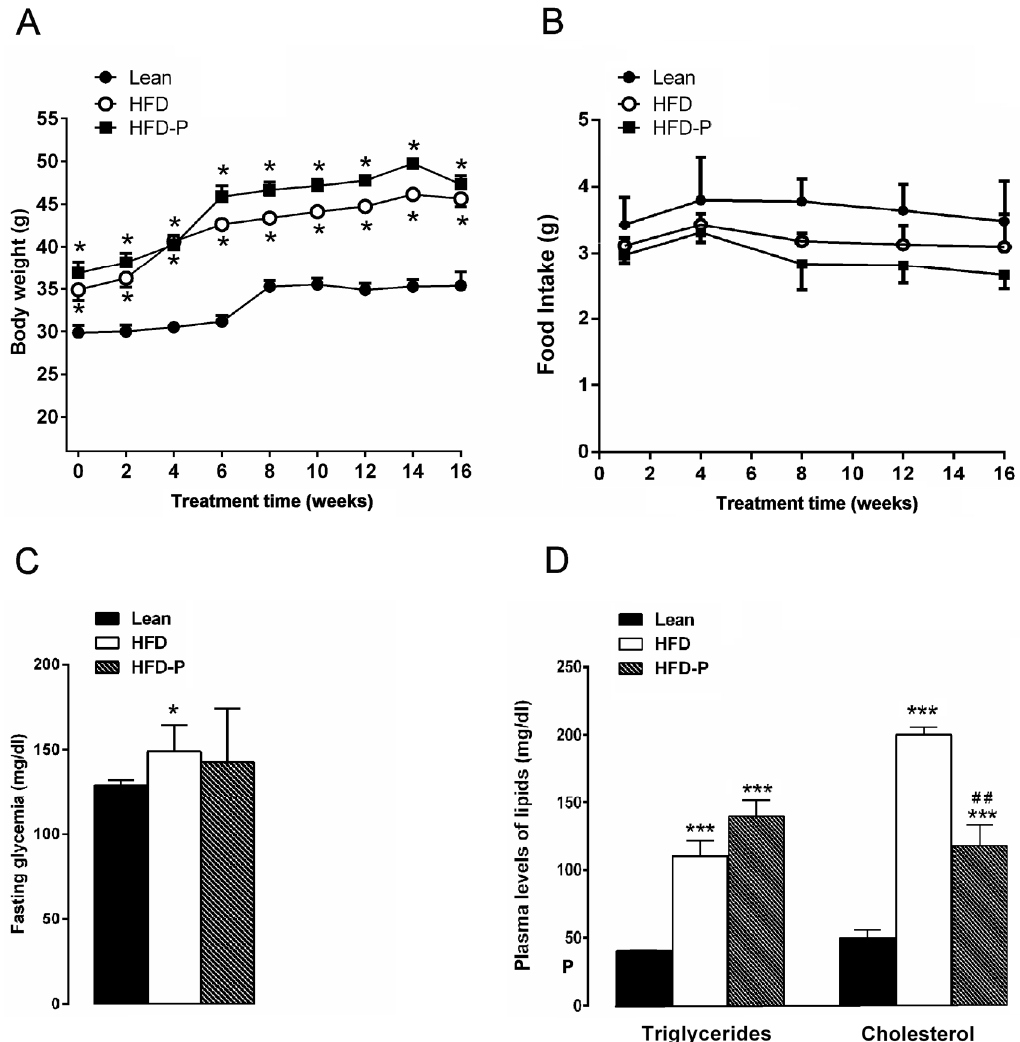
Figure 5. Pistachio consumption effects on body weight, food intake, fasting glycaemia, and plasma lipid levels in mice with ascertained obesity. Pistachio regular intake improves hypercholesterolemia. Body weight ( A ), food intake ( B ), fasting glycaemia ( C ), and plasma lipid levels ( D ) in lean, HFD, and HFD-P mice. Data are the means ± S.E.M. ( n = 8/group). Asterisk denotes significant difference compared with the lean group (* p < 0.05; ** p < 0.01; *** p < 0.001;); hash denotes significant difference compared with the HFD group ( # p < 0.05; ## p < 0.01; ### p < 0.001;).